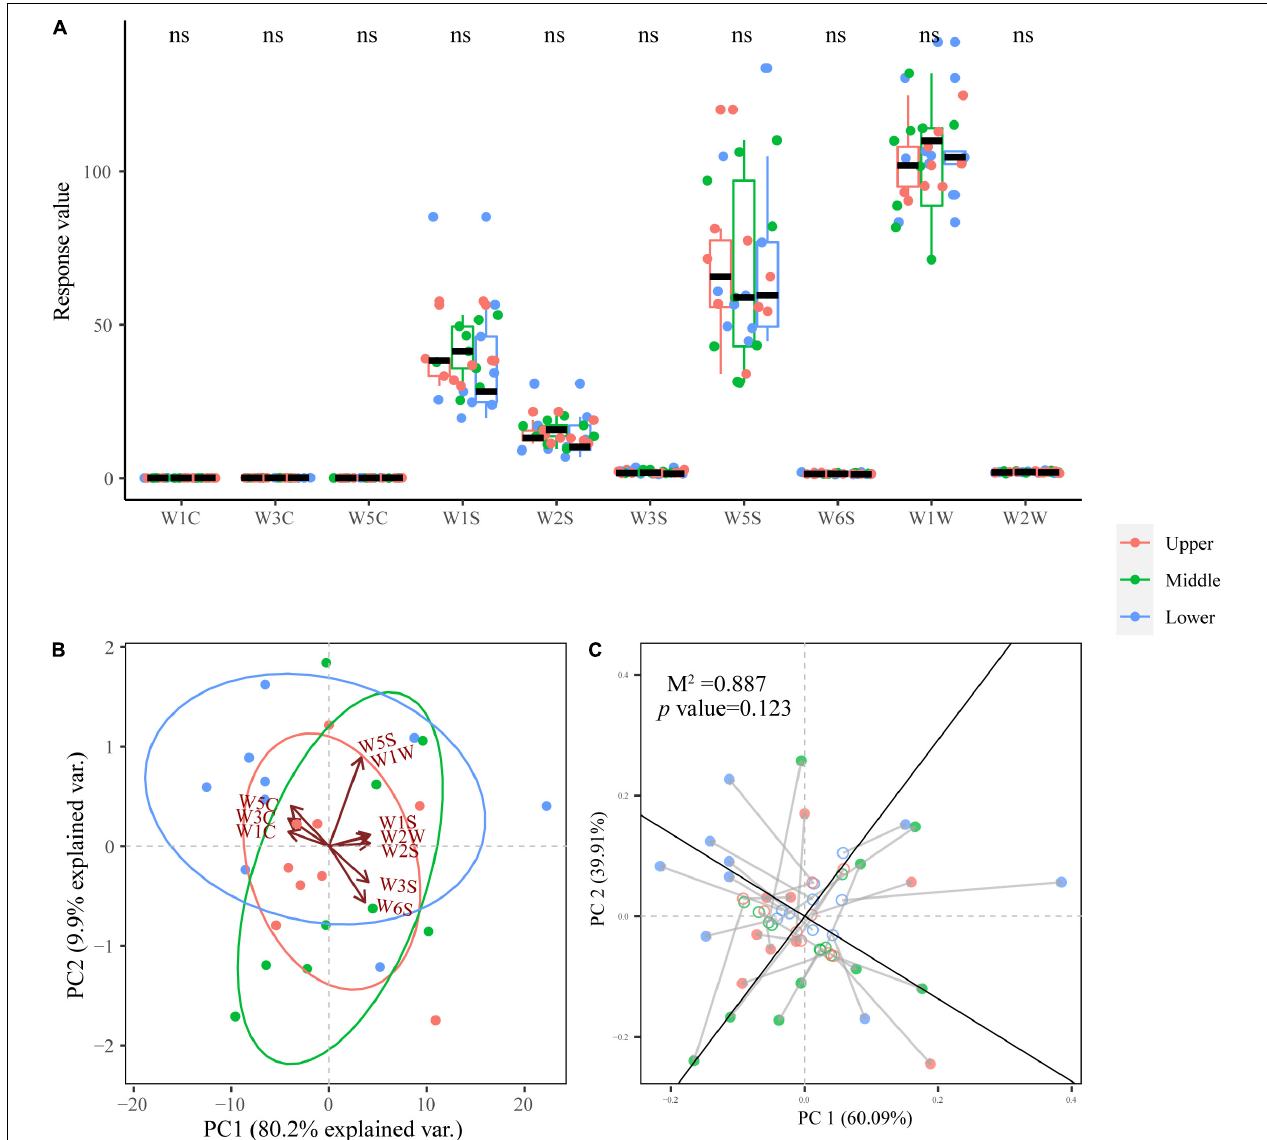
FIGURE 7 | Box plot for aroma profiles of PM samples at different depths (A) . PCA biplot based on the aroma profiles of PM samples (B) . Procrustes analysis of the correlation between dominant fungal genera and aroma profiles ( M 2 = 0.887, p = 0.123, 999 permutations) (C) .